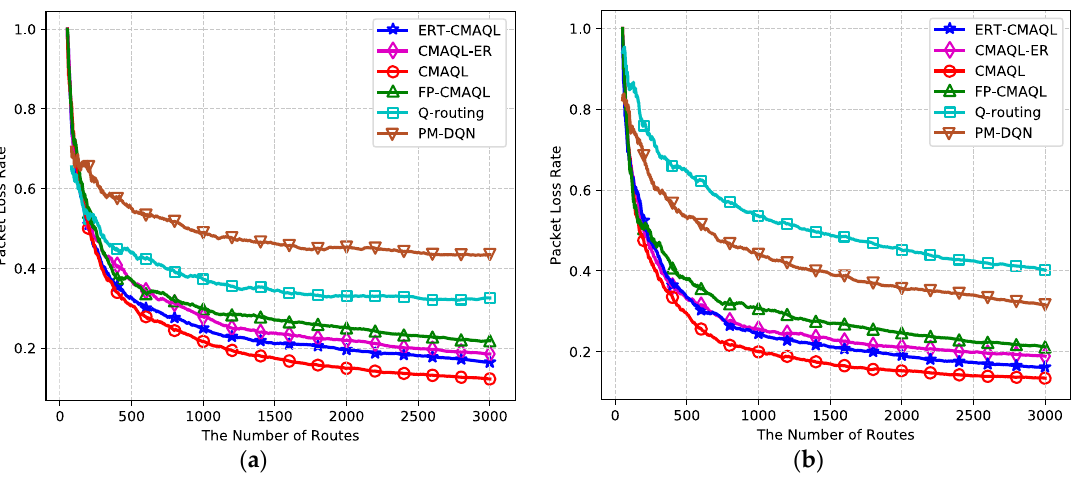
Figure 9. Packet loss ratio versus the number of routes: ( a ) 10 SU nodes, 4 PU channels and ( b ) 20 SU nodes, 10 PU channels.